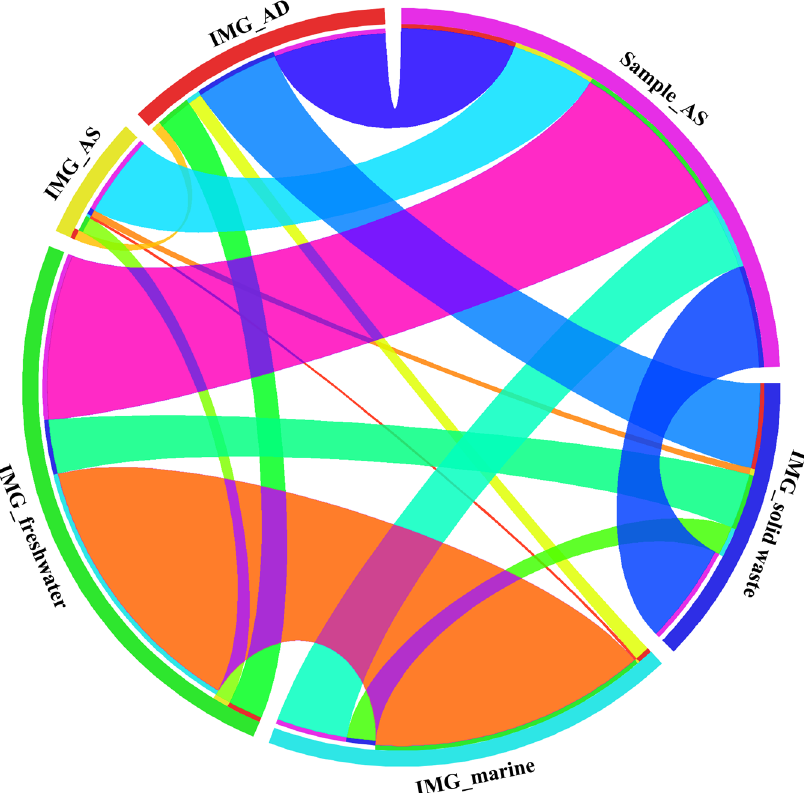
Fig. 6 Connections between viral genera in AS samples and in fi ve ecosystems from IMG/VR database. Pairwise connections were shown in a Circos 56 plot between samples and different ecosystems, including AS, AD, solid waste, freshwater, and marine water. Source data are provided as a Source Data fi